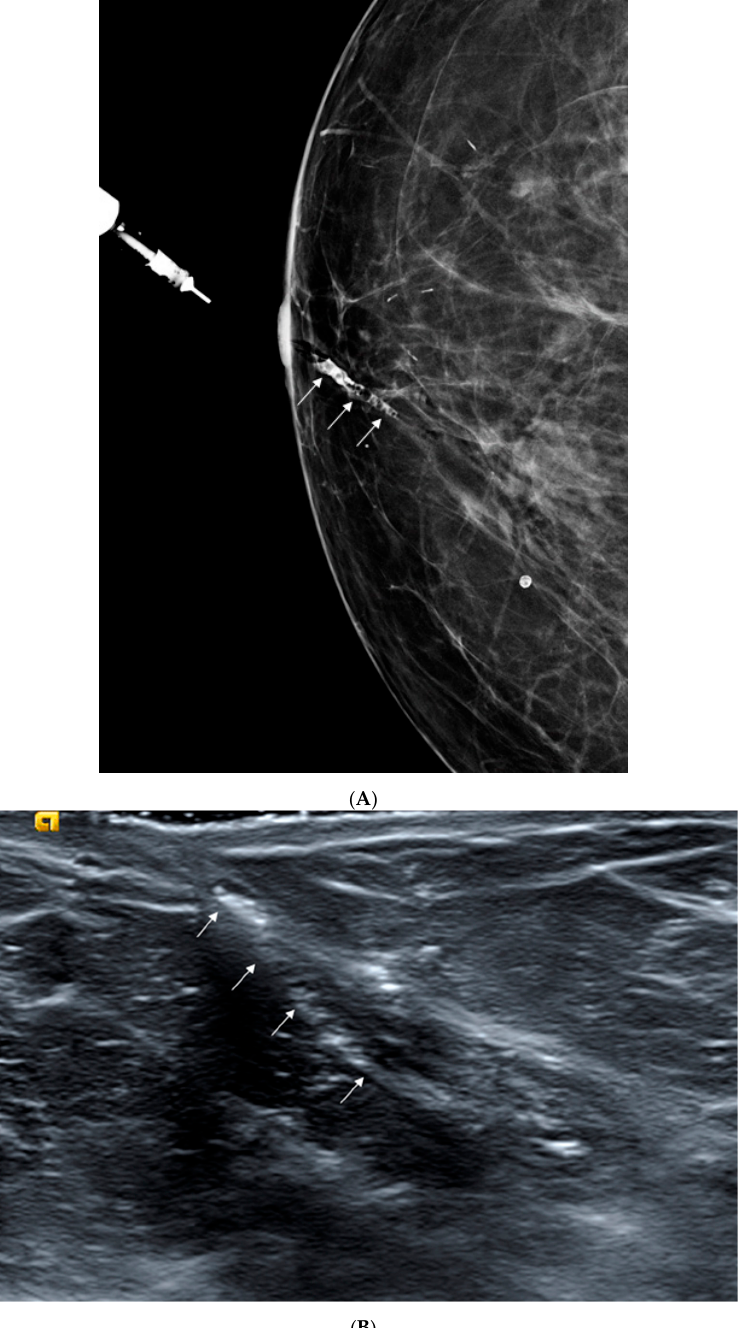
Figure 4. A 79-year-old woman with a pathological diagnosis of ductal carcinoma in situ. ( A ) Magnified galactogram which shows obstruction in the duct and microdefects with a moth-eaten appearance (arrows), which was included in the Galactogram Image Classification System (GICS) 5 category: high suspicion of malignancy. ( B ) Magnified sonogram showing a micronodular pattern and badly-defined duct wall (arrows), with hyperechoic foci which correspond to the contrast dye